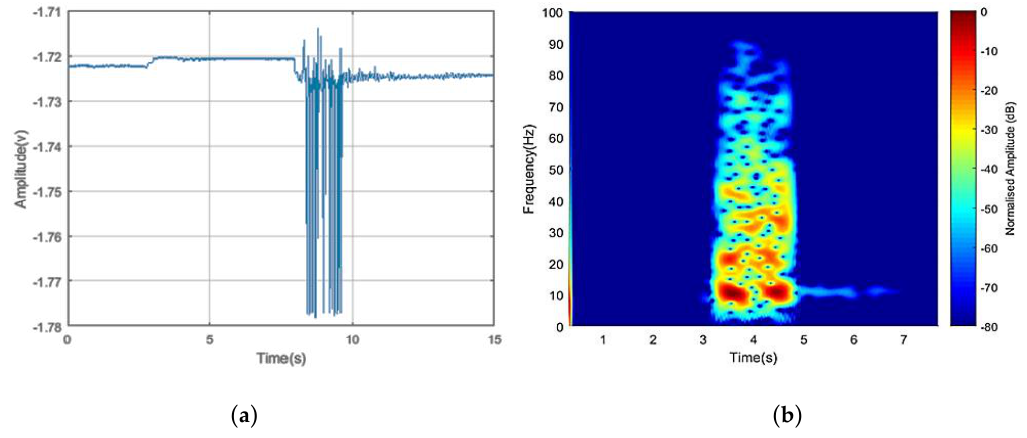
Figure 12. ( a ) Received signal (Signal 2) in time domain at the output of ADC, and ( b ) its joint time–frequency representation of the sampled signal (6–14 s) denoted as target signature.